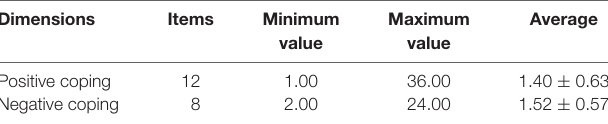
TABLE 6 | Total score of coping styles and score of each dimension in patients with complicated hepatolithiasis ( n = 156). Dimensions